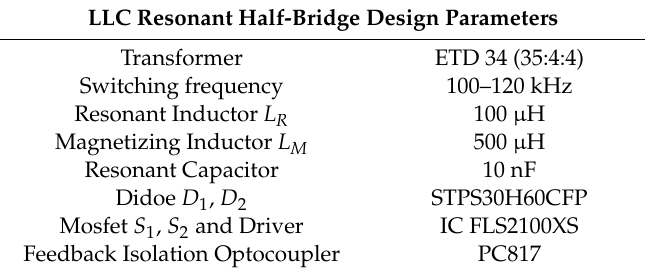
Figure 8. Voltage gain characteristics of the LLC resonant converter with the resonance frequency of 159 kHz, inductance ratio m = 6. Table 4. Device list in the LLC resonant DC ‐ DC converter.